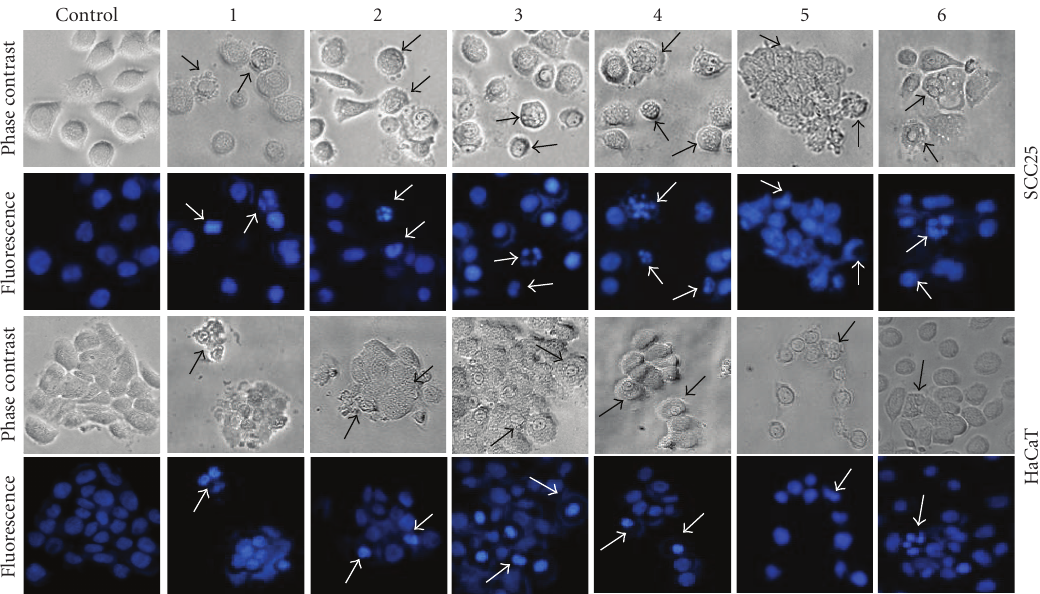
Figure 2: Morphological changes in SCC25 and HaCaT cells after the genus Sinularia extracts treatment. A constant concentration of extracts (IC 50 ) was added to the cells for 18 hours. The change was inspected by a phase-contrast-inverted microscopy. The cells were then fixed in 4% paraformaldehyde and DNA stained with Hoechst. The nuclei of the cells were visualized using a fluorescent microscope (200 × ). S . grandilobata , 1; S . parva , 2; S . triangula , 3; S . scabra , 4; S . nanolobata , 5; and S . gibberosa , 6.